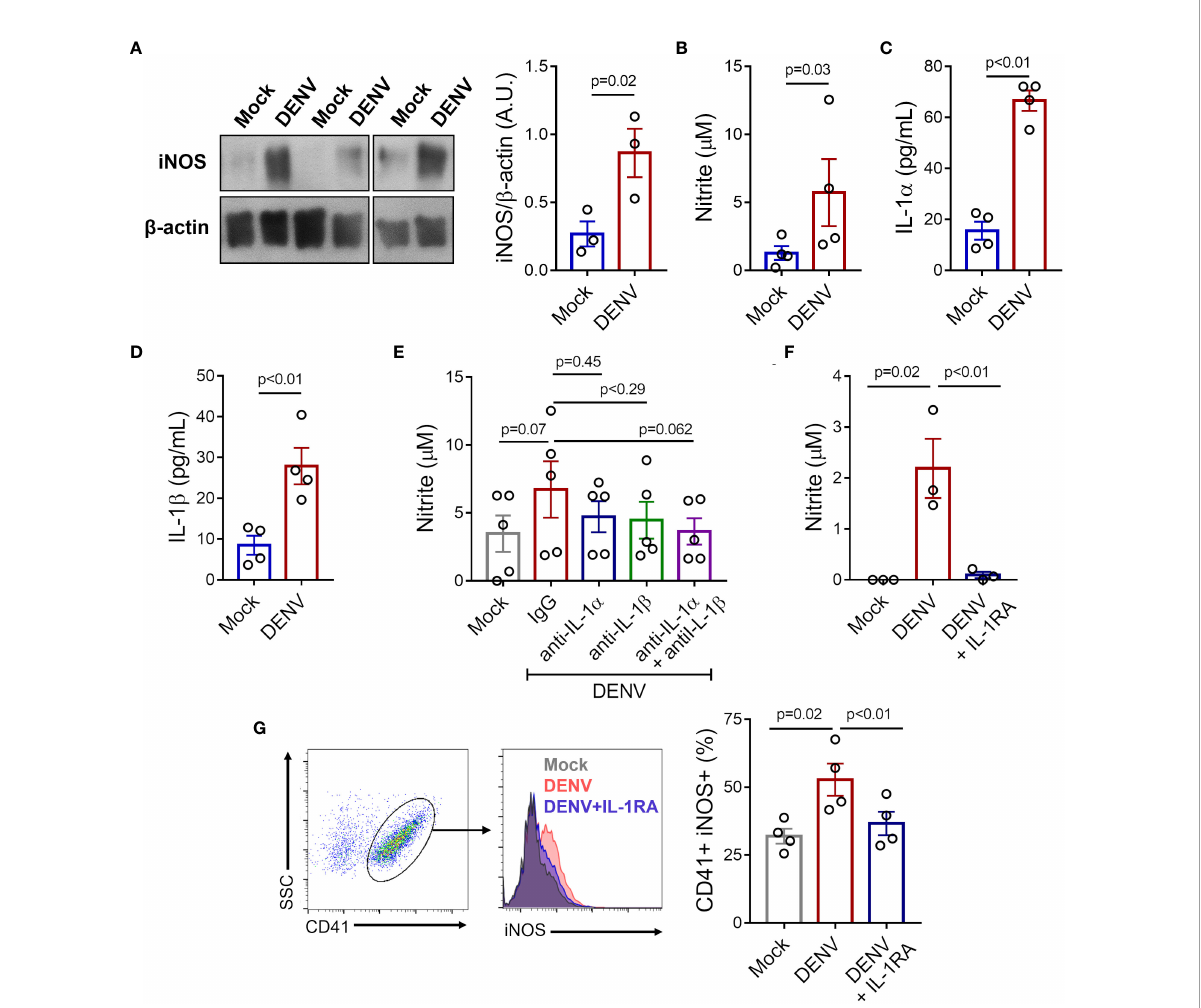
FIGURE 6 DENV induces iNOS expression and NO production in platelets through IL-1R. Platelets from healthy volunteers were stimulated with DENV-2 (MOI= 1) or Mock for 6 hours. (A) Expression of iNOS was analyzed by western blot in platelet lysates. b -actin was used as load control. Band densitometry of iNOS expression corrected by b -actin expression is shown (A.U., arbitrary units). (B-D) Quanti fi cation of (B) nitrite (C) IL-1 a and (D) IL-1 b in the supernatant of platelet in each condition. (E-G) Platelets from healthy volunteers were infected with DENV-2 in the presence or absence of IL-1RA, anti-IL-1 a , anti-IL- b , or isotype-matched control antibody. (E, F) Nitrite concentration in the supernatant is shown for each condition. (G) The percentage of platelets with intracellular labeling for iNOS after infection with DENV in the presence or absence of IL-1RA. Representative histograms are shown. The bars represent mean ± SEM of 3 (panels (A, F) ), 4 (panels (B-D, G) ), or 5 (panel (E) ) independent experiments with platelets from different healthy